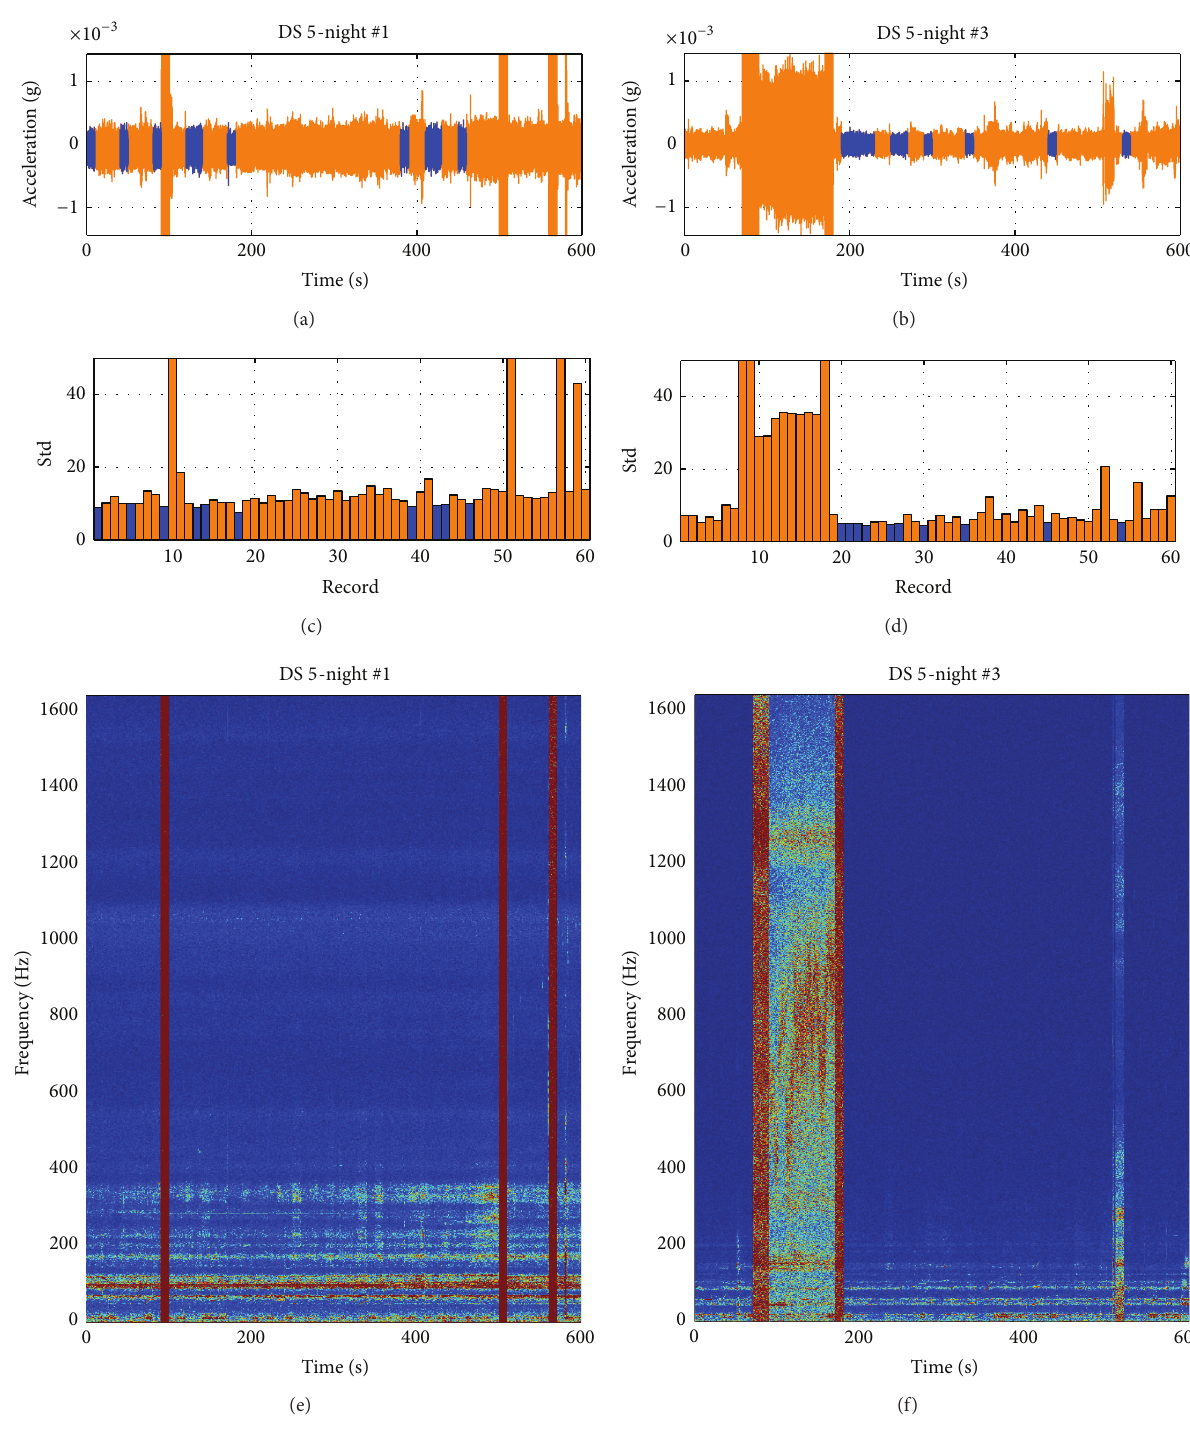
Figure 4: Investigation of signals related to nights #1 and #3 of dataset DS 5 (a), (b) complete time history; (c), (d) STD values; (e), (f) time-frequency